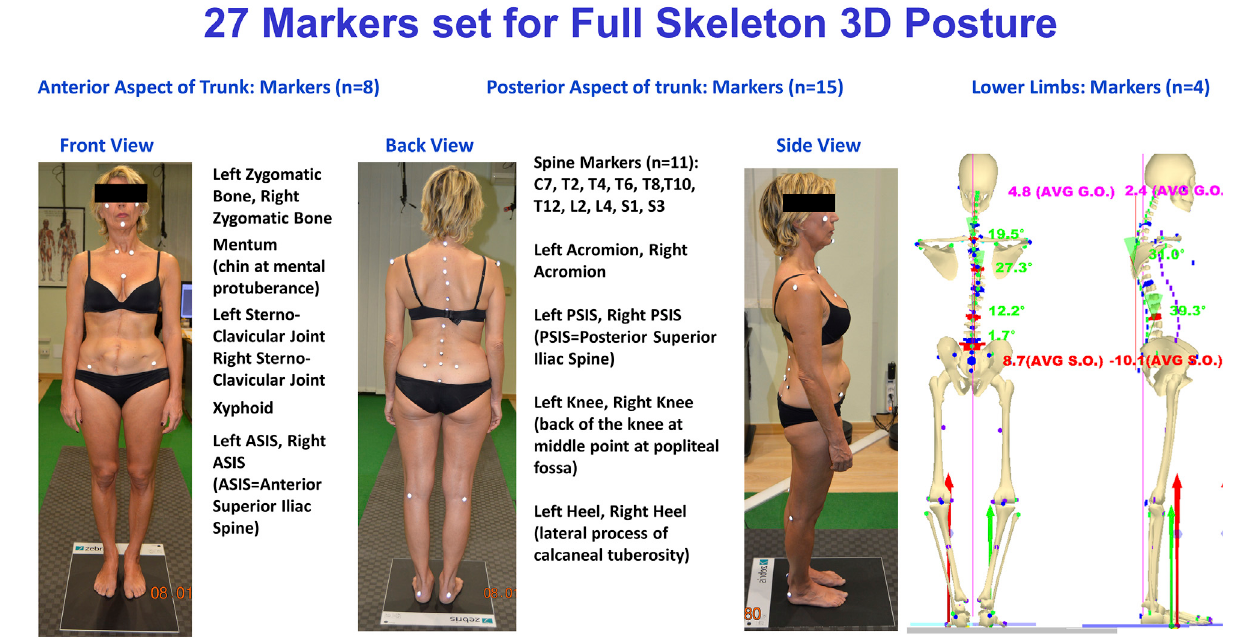
FIGURE 1 | The experimental setup used for 3-D posture analysis: GOALS system and baropodometric platform con fi guration.